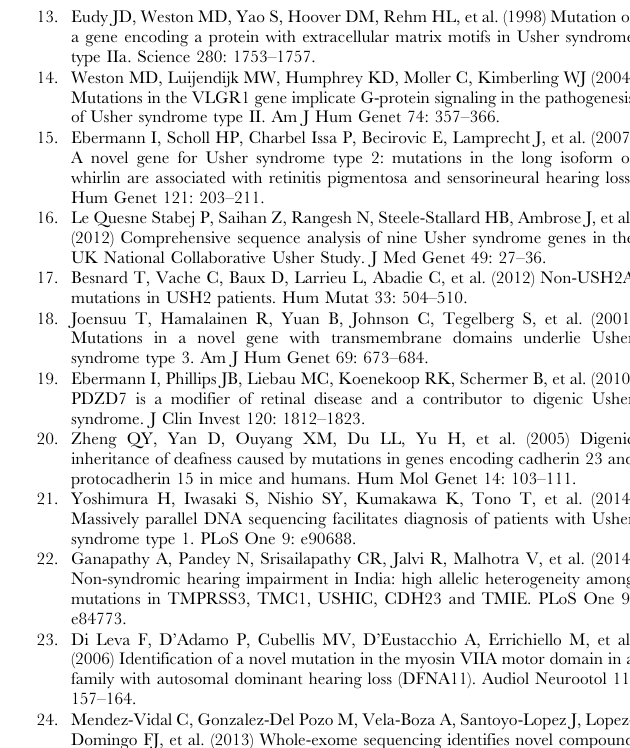
Figure S1 Pedigrees of the Usher syndrome type 1 families analyzed in this study. (TIF) Figure S2 Pedigrees of the Usher syndrome type 2 families analyzed in this study. (TIF) Figure S3 Chromatograms of the patients with MYO7A , GPR98 , USH2A and CDH23 mutations. (PDF) Table S1 Segregation of the identified mutations in the analyzed USH1 families. (XLSX) Table S2 Segregation of the identified mutations in the analyzed USH2 families. (XLSX) Table S3 Sequence coverage of the 10 Usher genes in whole exome sequencing. (XLSX)